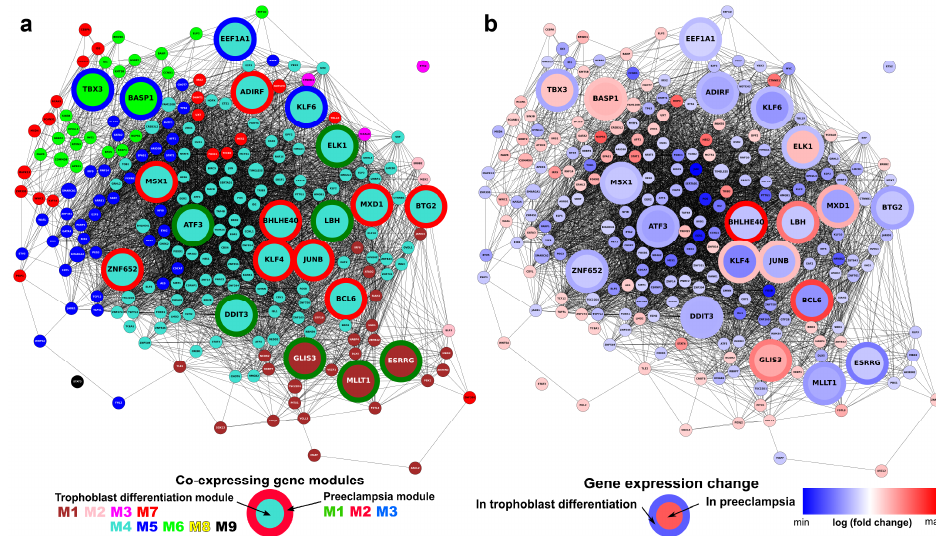
Figure 10. Co-expression network of transcription regulatory genes involved in villous trophoblast differentiation and preterm preeclampsia. The co-expression network of 220 DE transcription regulatory genes is shown; genes with an absolute expression correlation coefficient >0.9 are connected. The 20 genes that are also differentially expressed in preeclampsia [57] are shown in larger size. ( a ) The relationship of villous trophoblast (VT) differentiation gene modules and preterm preeclampsia DE gene modules. Node color represents VT differentiation gene module (colors are defined in Figure 4), while border color of the large nodes represents preeclampsia gene module as defined earlier [57]. ( b ) Relationship between fold changes during VT differentiation and in preterm preeclampsia. Node color indicates the log 2 fold change of genes in VT differentiation, while border color of the large nodes indicates log 2 fold change in preterm preeclampsia [57]. (Visualizations created with Tabnetviz (git.io/tabnetviz)).